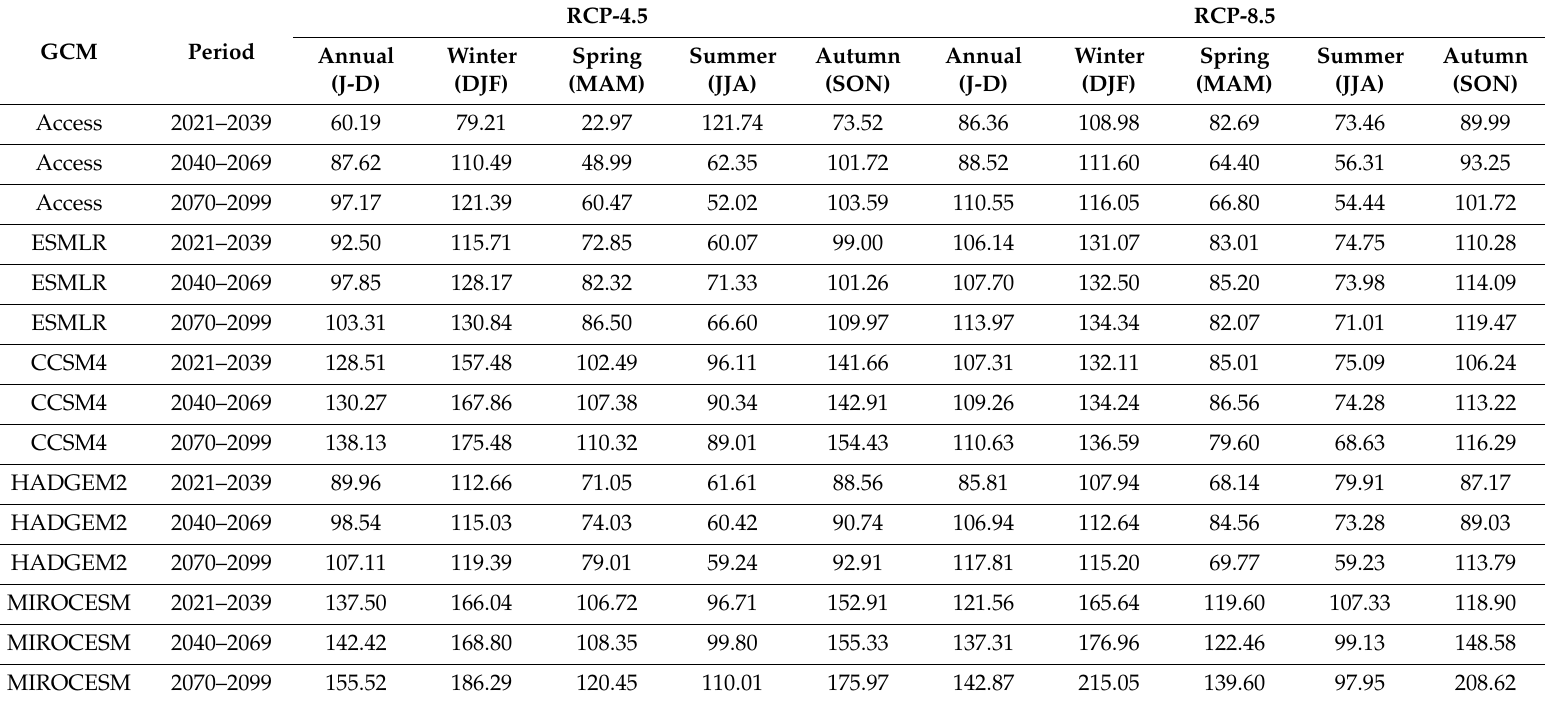
Table 7. Average annual and seasonal flow change in percentage (%) under RCP 4.5 and RCP